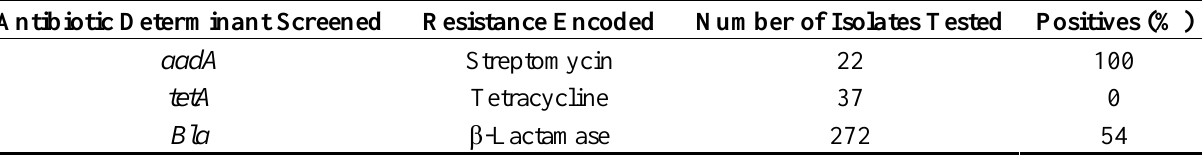
Table 5. Incidence of some antibiotic resistance determinants